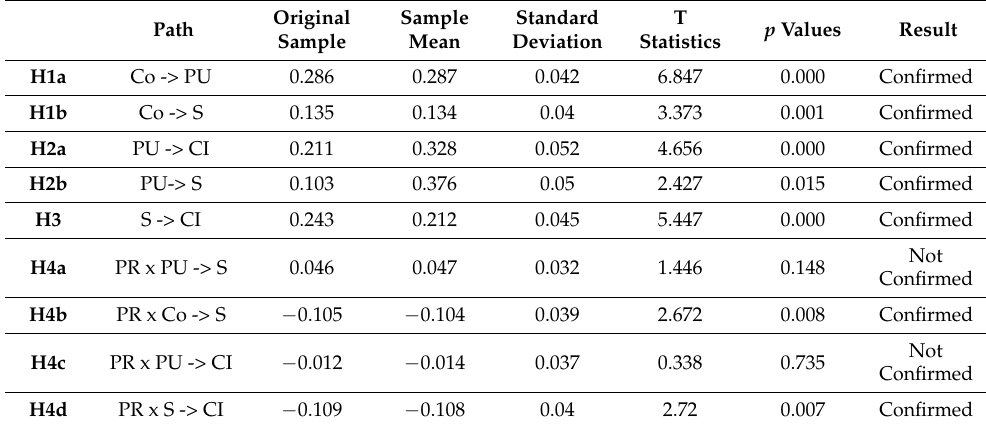
Table 6. Assessment of Structural Model.